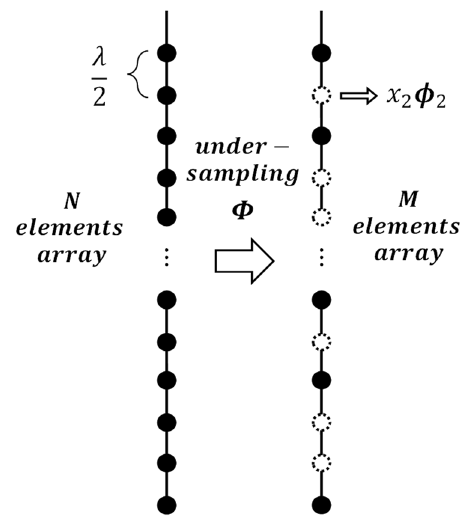
Figure 3. The process of under-sampling array.